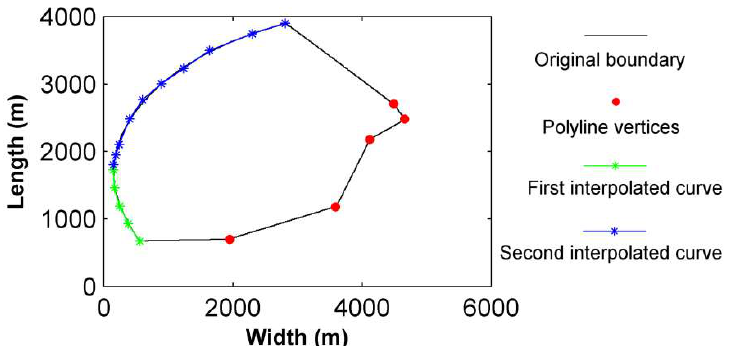
Figure 1. Diagram of the irregular wind farm boundary representation.